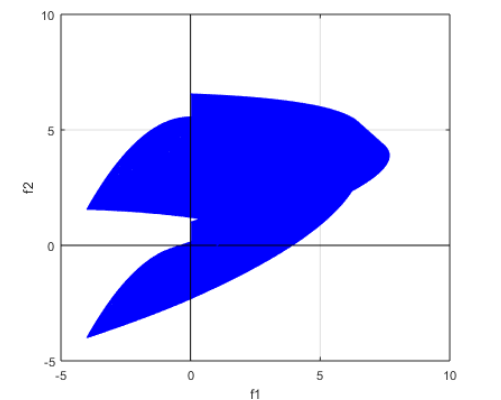
Figure 4. Payoff space of the coopetitive game G µ ; that is, the union of all payoff spaces of the games G µ ( z ) , with z ∈ C